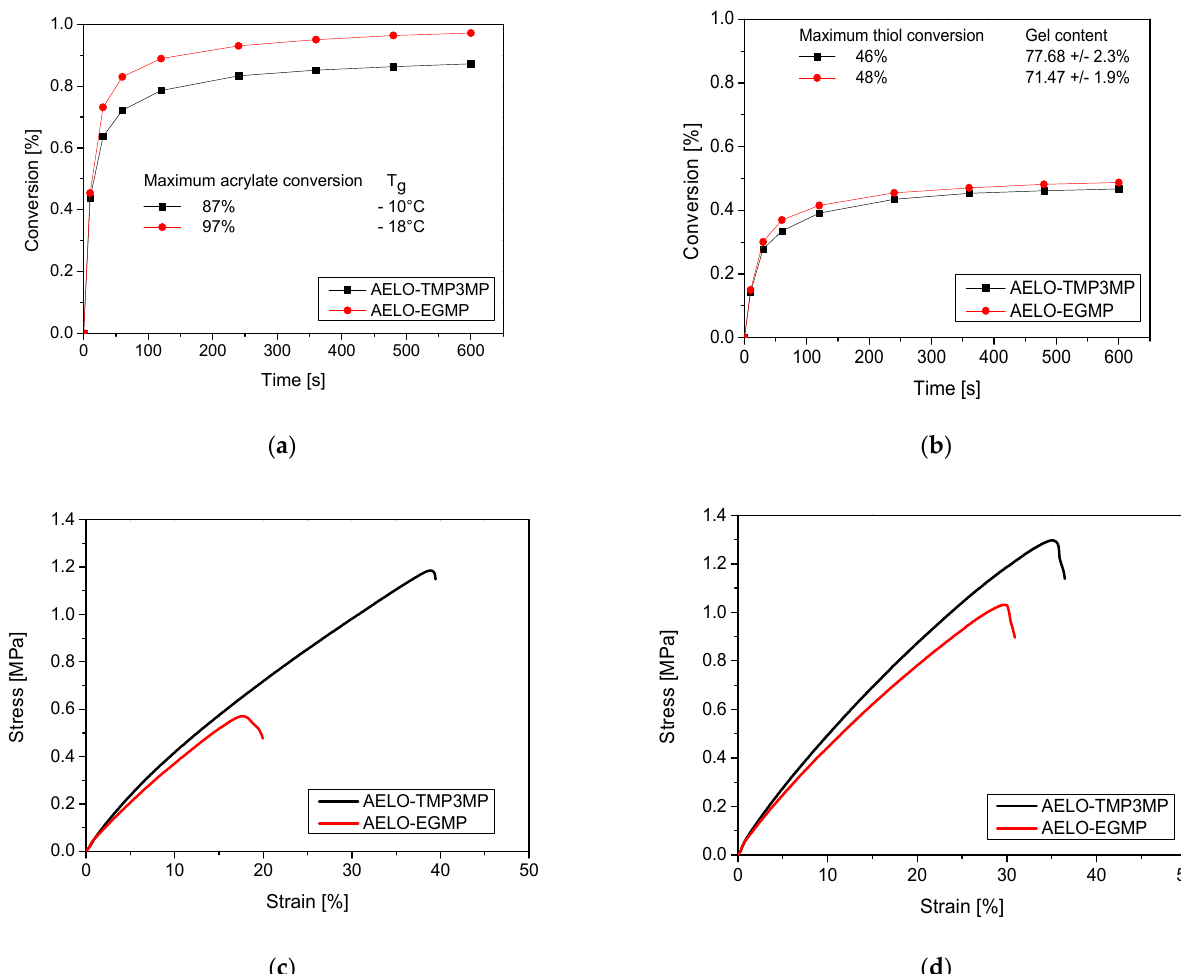
Figure 3. Monitoring of the conversion of ( a ) acrylate (1635 cm − 1 ) and ( b ) thiol (2520 cm − 1 ) groups over illumination time (405 nm, 3.3 mW cm − 2 ) via FTIR experiments. Stress–strain curves of AELO-EGMP and AELO-TMP3MP photopolymers ( c ) prior to and ( d ) after thermal treatment (180 ◦ C, 4